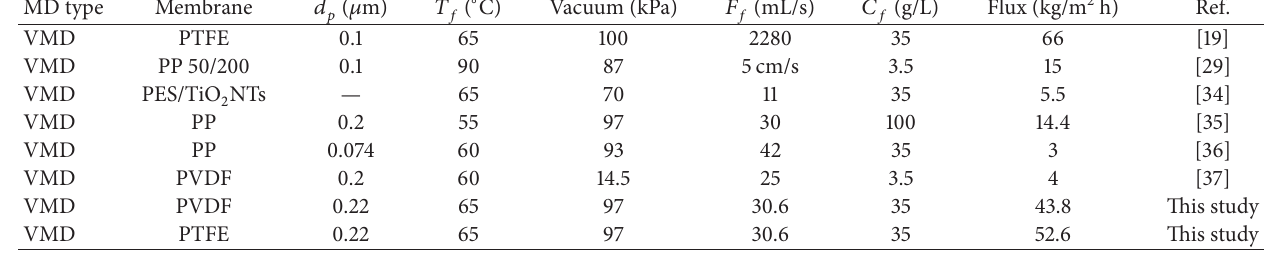
Table 7: Comparison of the permeate fluxes at different operating conditions in MD for different NaCl solutions.